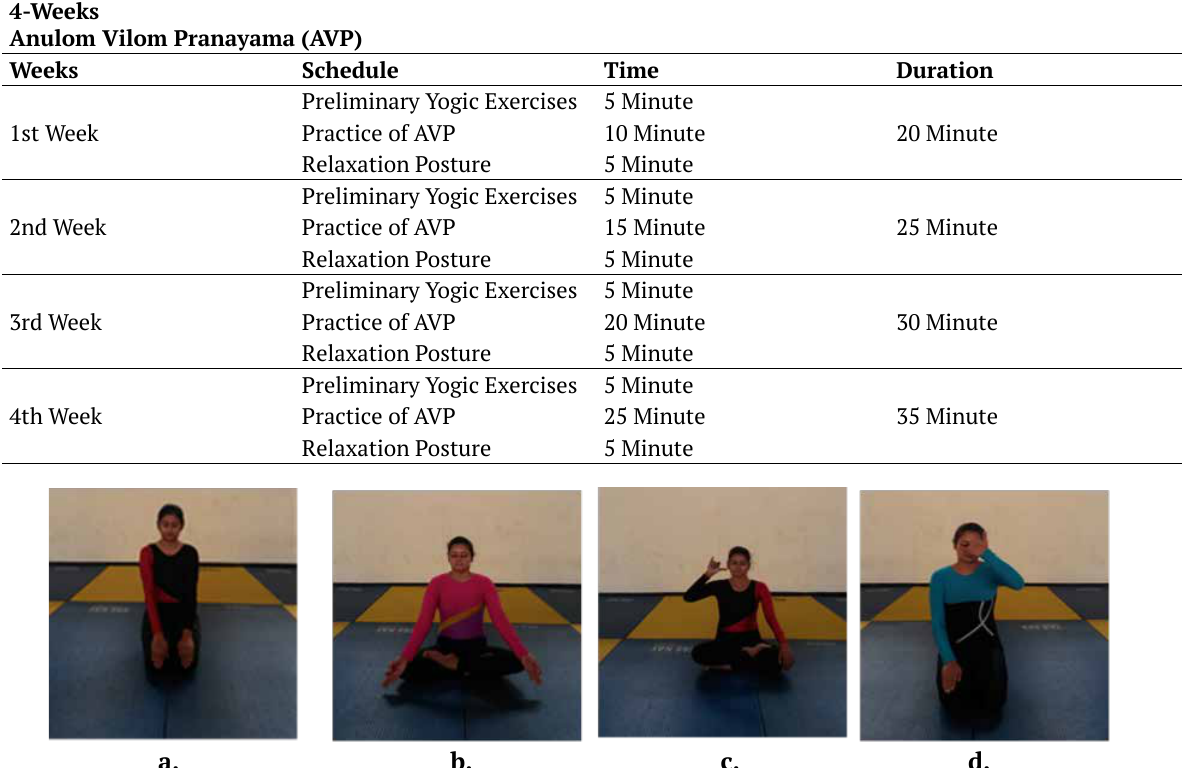
Figure 2. Steps followed by participants in Anulom Vilom intervention